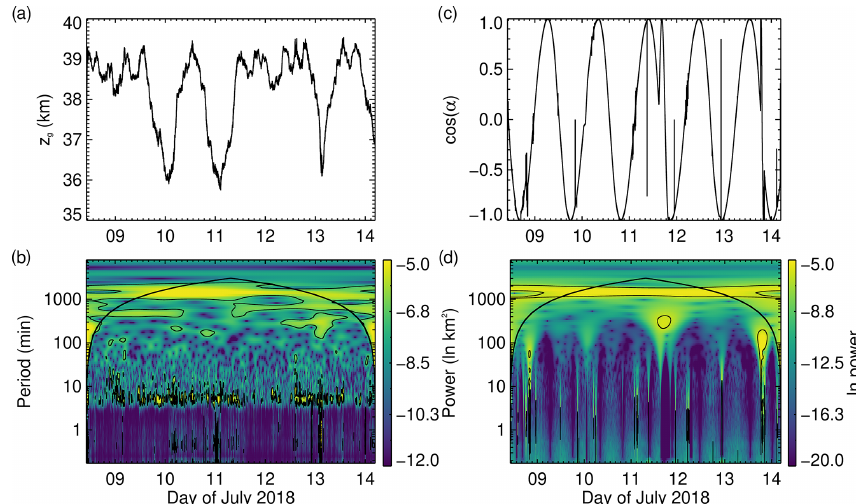
Figure 1. (a) Interpolated floating altitude z g and (b) its wavelet spectrum, showing a dominant diurnal motion and a buoyancy motion of a 5min period. (c) Cosine of the azimuth angle α and (d) its wavelet spectrum, including short losses of pointing stabilization around the 1min period and tests during non-PMC conditions and prior to